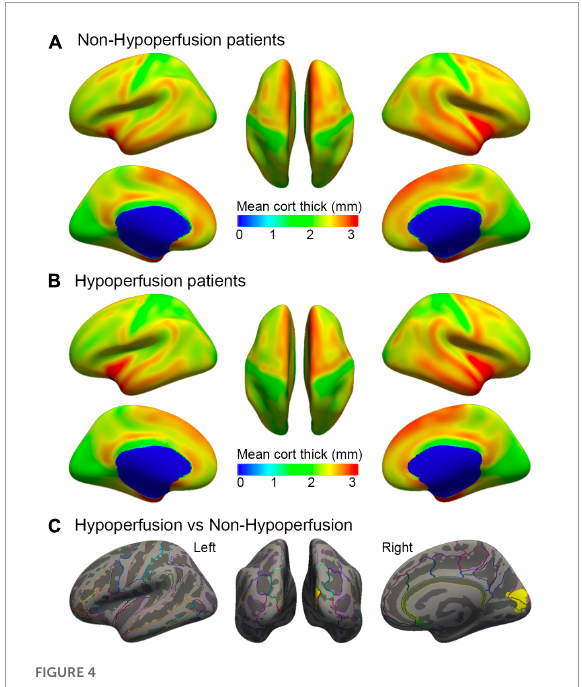
FIGURE4 Comparisons of cortical thickness in patients with different perfusion status at stroke onset. Surface representation of mean cortical thickness for hemispheres in subgroups without hypoperfusion (A) and with hypoperfusion (B) . Color bar indicates cortical thickness changes in millimeter. (C) Representation of the statistically significant clusters showing a decline in cortical thickness in the right cuneus (cluster size = 1177.58 mm 2 ; coordinates: x = 5.6, y = − 67.7, z = 14.0; P = 0.0002, corrected for multiple comparisons), when controlling for demographic variables and lesion